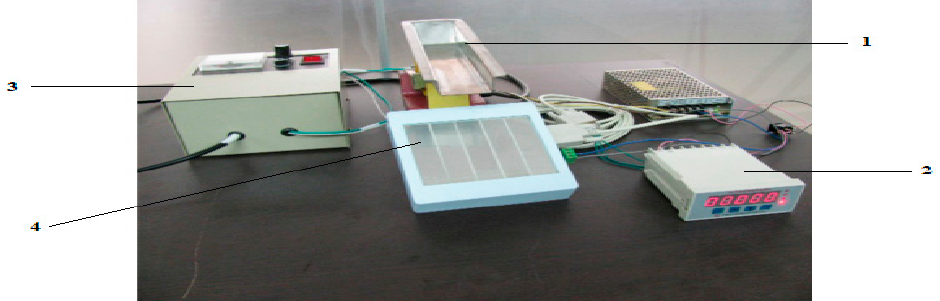
Figure 15. Installation of the experimental system. 1—grain conveyor, 2—display counter, 3—signal conditioning circuit box, 4—sensor platform [51].